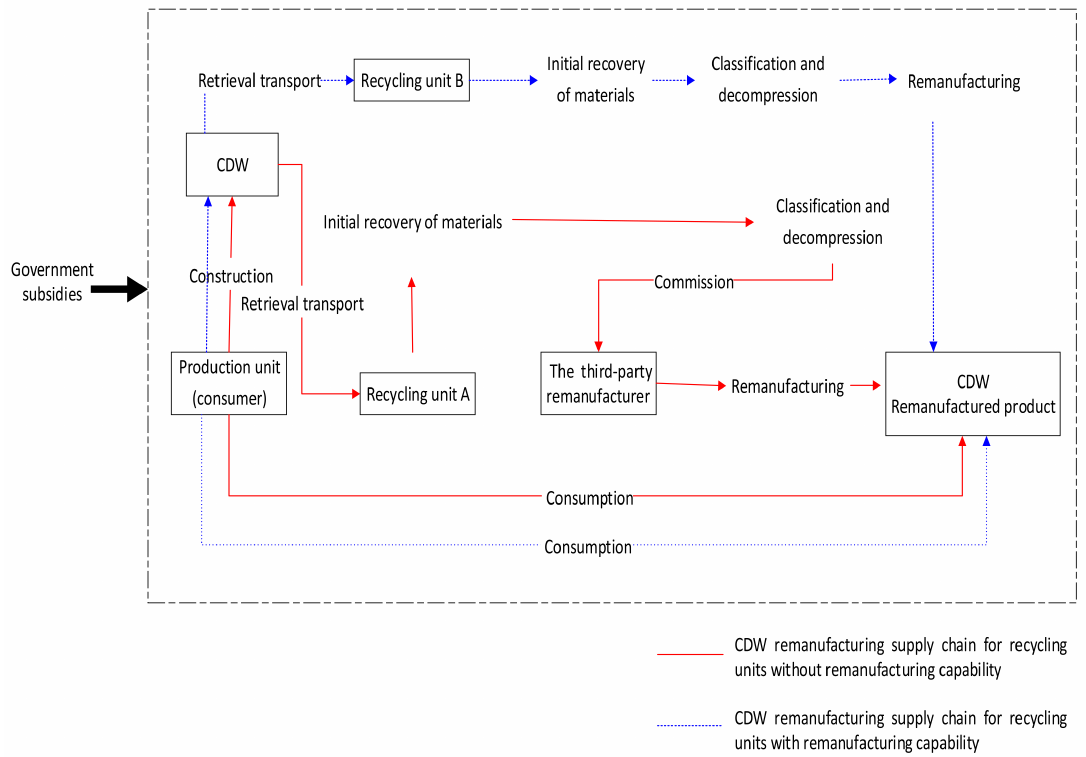
Figure 1. Flow chart of remanufactured CDW products’ supply